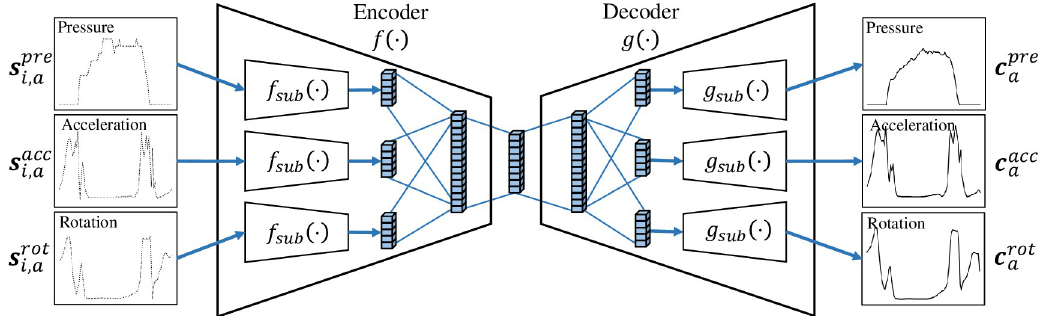
Fig 4. Illustration of the encoder–decoder architecture. The encoder and decoder include three sub-encoders and sub-decoders for multimodal sensing.